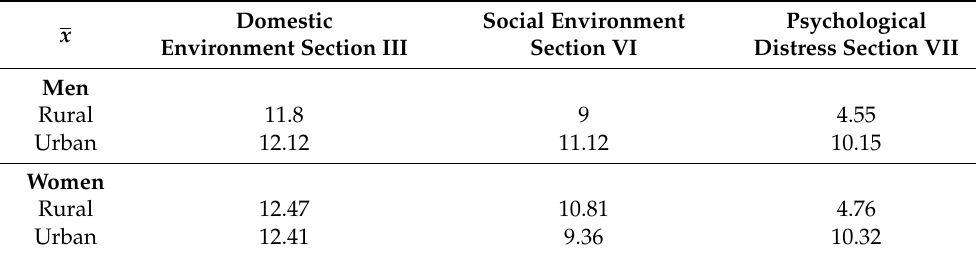
Table 5. Mean scores for Sections III, VI and VII of the PAIS-SR by sex and place of residence. Source: own